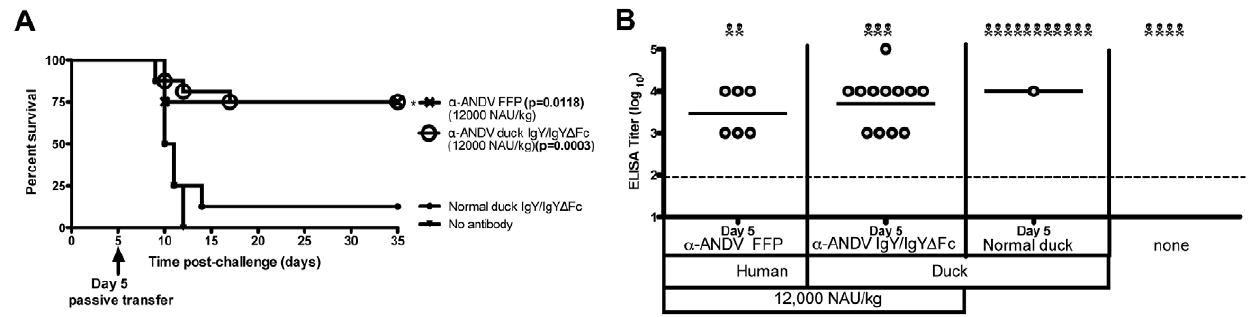
Figure 6. 12,000 NAU/kg of anti-ANDV duck IgY/IgY D Fc protects hamsters from lethal HPS disease. A) Survival curve of hamsters that were challenged with 200 PFU i.m. of ANDV on day 0 and passively transferred with a -ANDV FFP (8 hamsters per group) or a -ANDV duck IgY/IgY D Fc (16 hamsters per group) on day 5 postinfection. * indicates statistical significance when compared to normal IgY/IgY D Fc treatment. B) a -N ELISA endpoint titers (log 10 ) were conducted with sera from surviving hamsters challenged with ANDV in A). GMT for each group are shown.